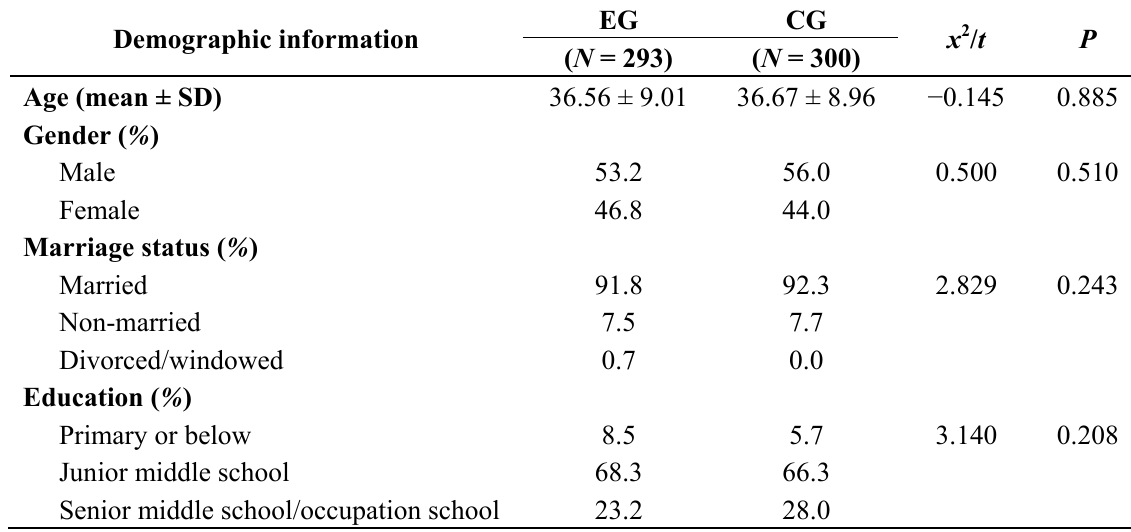
Table 1. Baseline characteristics of participating rural